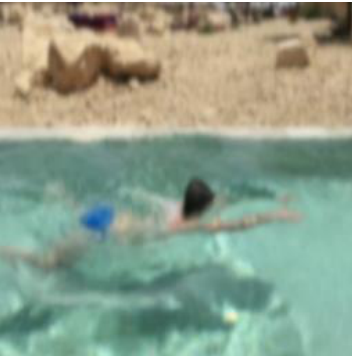
Figure 4. Images used in experiment 2 and captions generated using each method. Activity represents the image content. Activity ( a ) is that people are doing gymnastics in the room. Activity ( b ) is that a person is swimming in the water. Captions in black font were generated using the previous method [6]. Captions in green font were generated using the previous method [1]. Captions in blue font were generated using an earlier method [4]. Captions in red font were generated